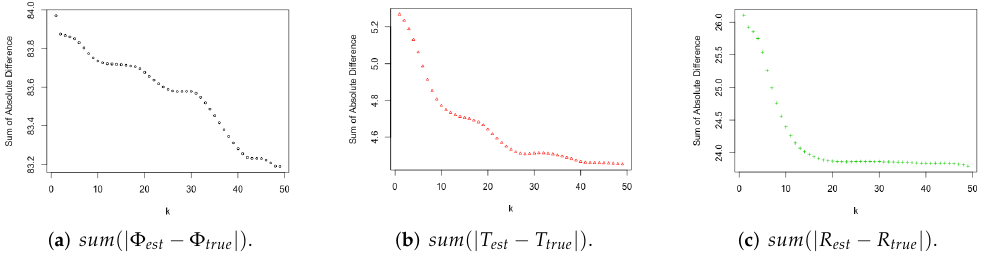
Figure 5. Plot of differences before and after switching order j and j + 1 ( j = 1,2,3, . . .